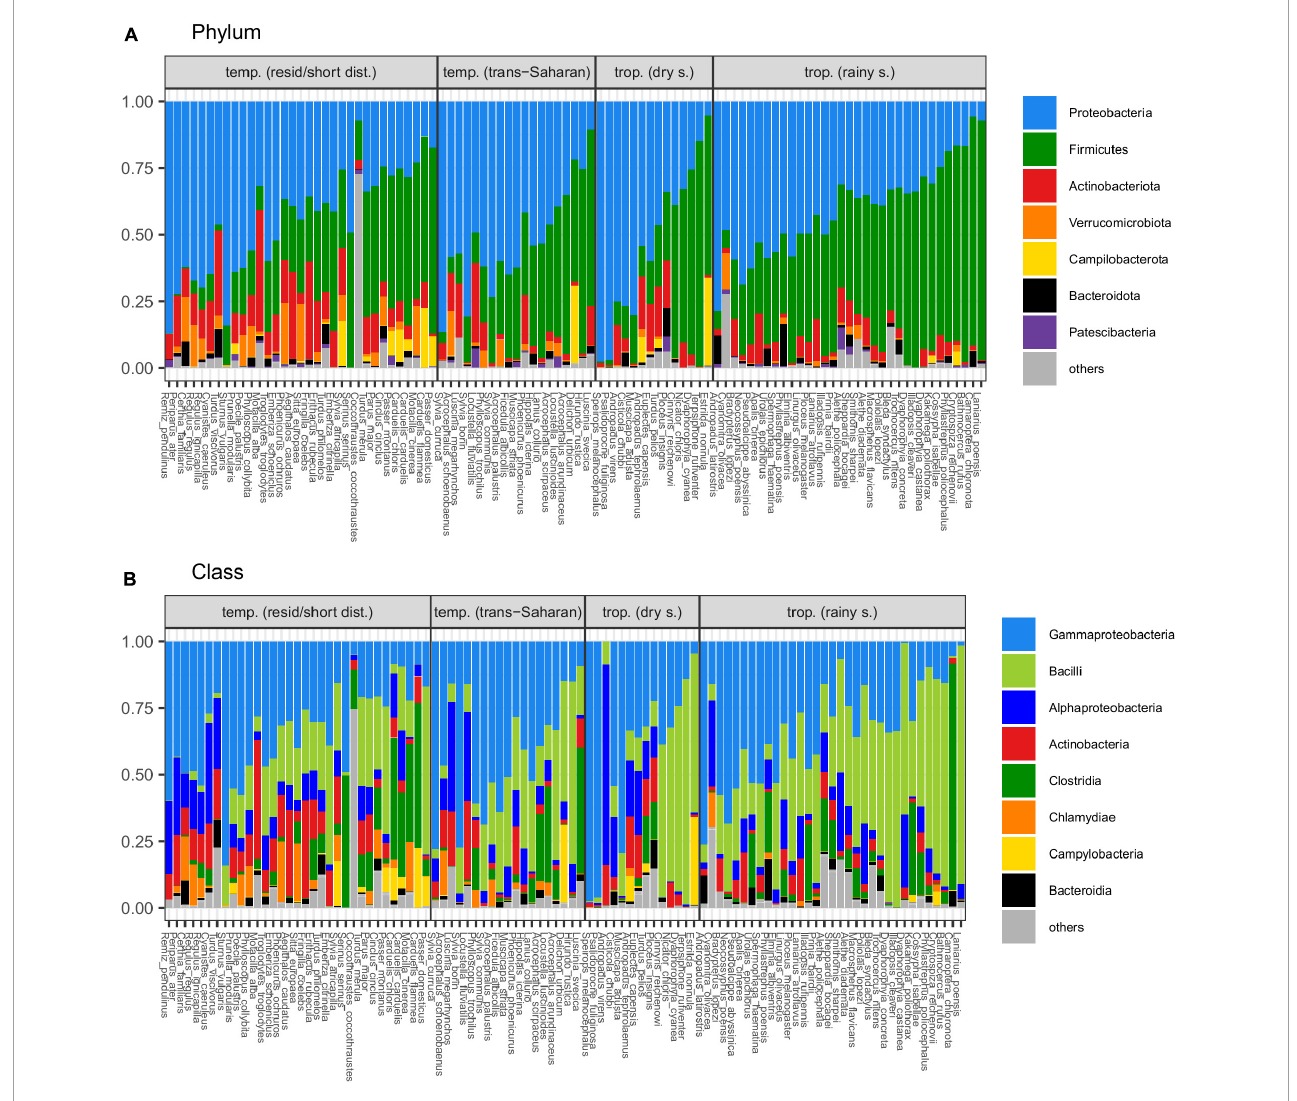
FIGURE3 Average proportions of dominating bacterial (A) phyla and (B) classes in gut microbiota (GM) of individual passerine species (“others” indicates taxa representing < 1% of whole